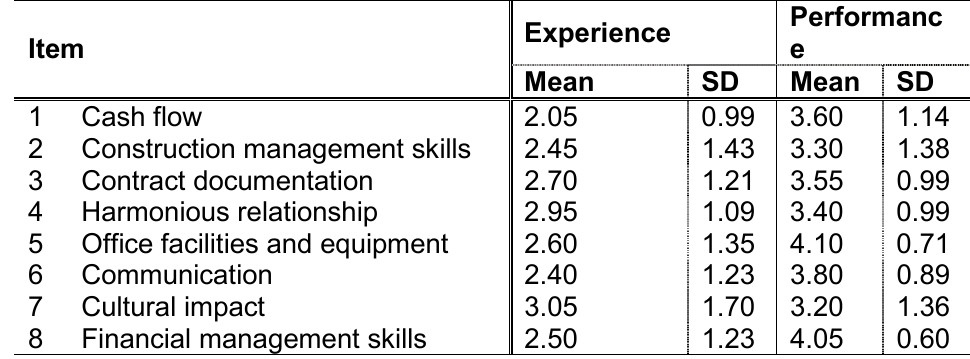
Table 3: Extent of experience and effect on